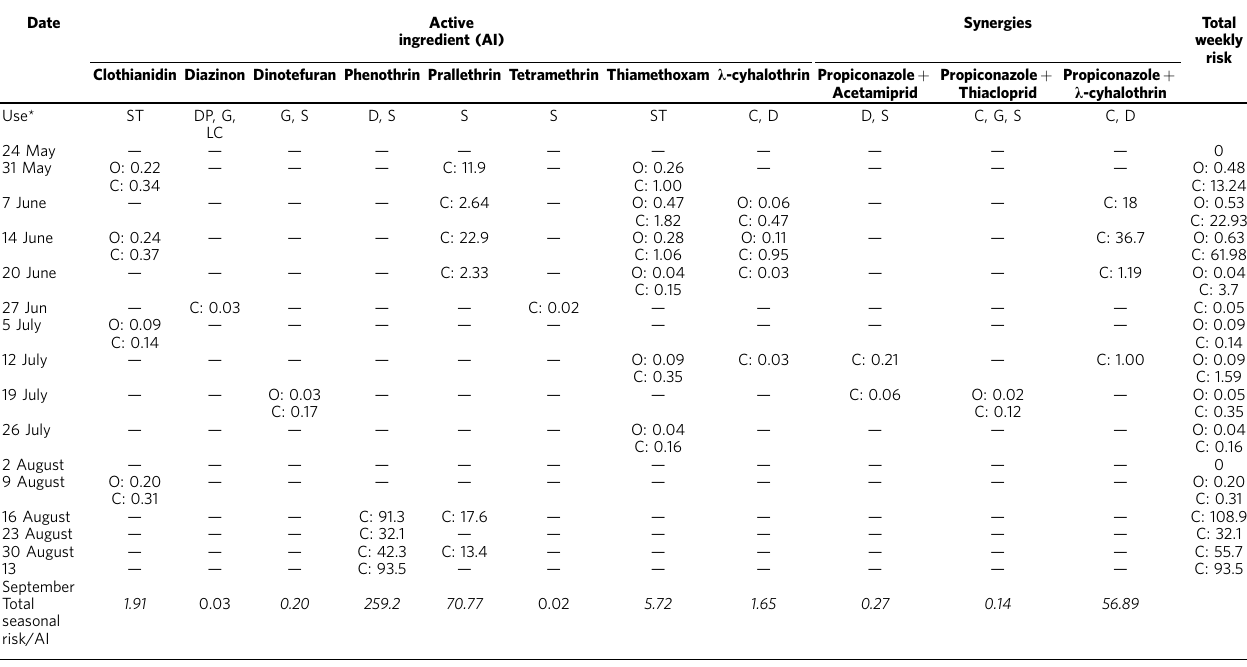
Table 4 | The average risk (%) posed by pesticide residues in pollen collected by honey bees placed next to an untreated maize field.